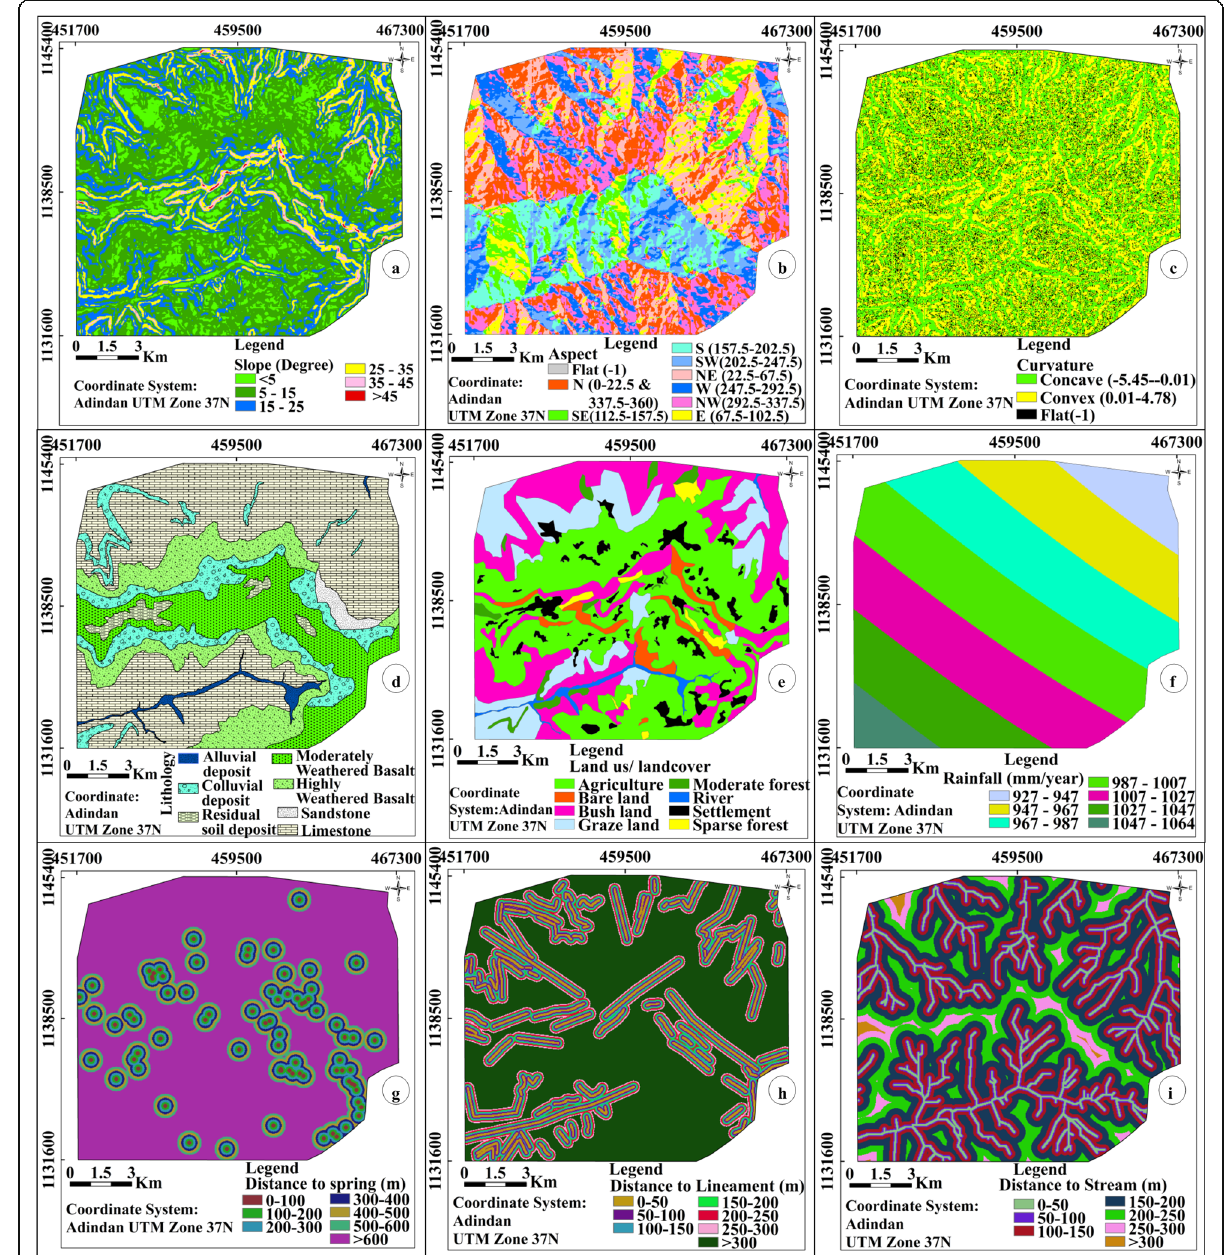
Fig. 6 Landslide causative factor maps: a Slope ( b ) Aspect ( c ) Curvature ( d ) Lithology ( e ) Land use/Land cover ( f ) Rainfall ( g ) Distance to spring ( h ) Distance to lineament ( i ) Distance to